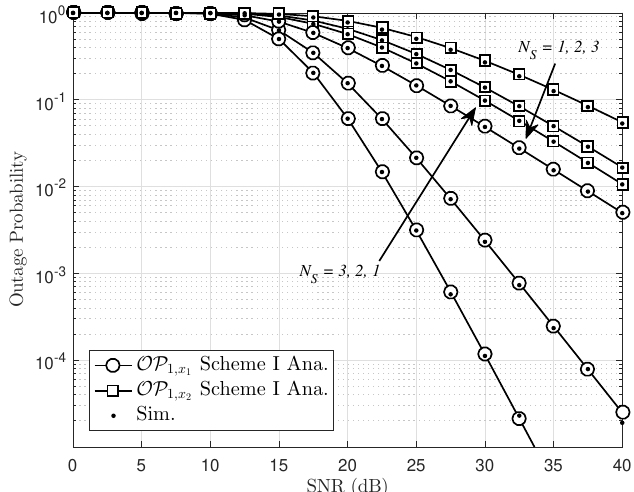
Figure 2. Outage probability of Scheme I with different numbers of transmit antennas at the BS ,